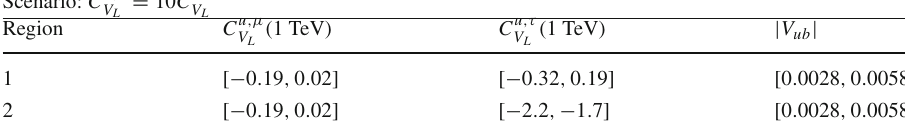
Table 3 Allowed ranges for the left-handed vector coefficients and | V ub | in the scenario where